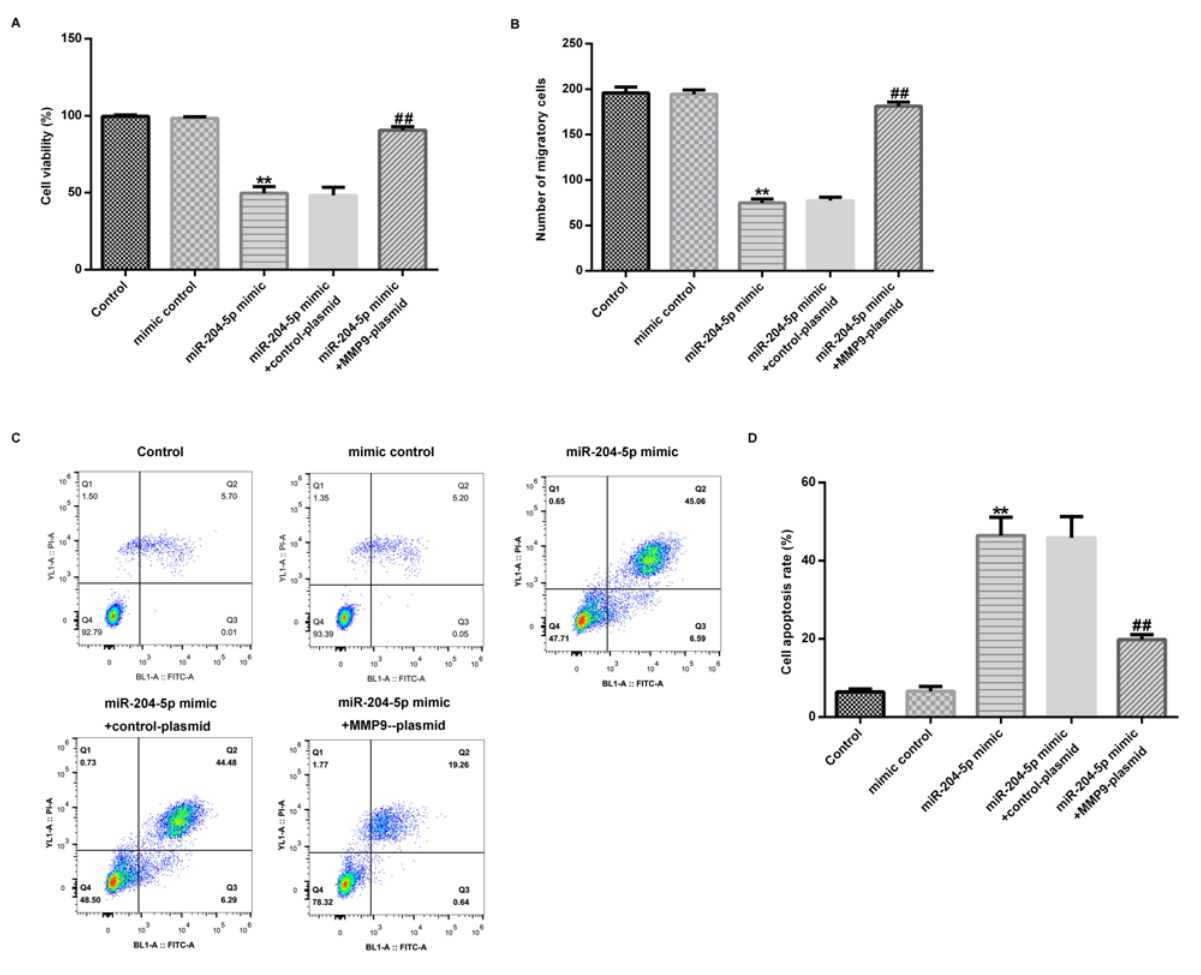
Figure 5: Overexpression of MMP-9 abrogated the inhibition of miR-204-5p mimic on hVSMC growth and migration. hVSMCs were respectively transfected with mimic control, miR-204-5p mimic alone or accompanied with control-plasmid or MMP-9-plasmid for 48 h. (A) MTT assay was used to detect cell viability of hVSMCs. (B) The transwell assay was performed to check cell migration. (C and D) hVSMC apoptosis was detected by flow cytometric assay. Results were presented as mean ± SD. **p < 0.01 vs. Control group; ## p < 0.01 vs. miR-204-5p mimic